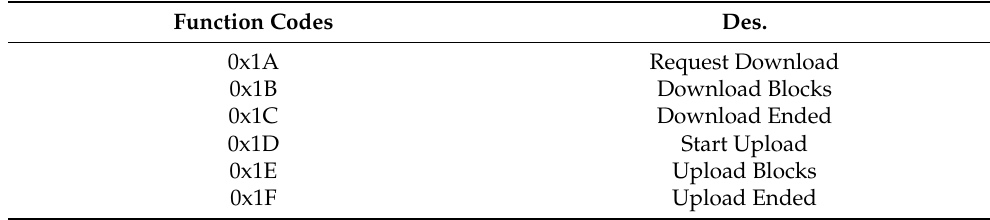
Table 7. Upload and Download Function Codes of the S7Comm Protocol. Function Codes Des. 0x1A Request